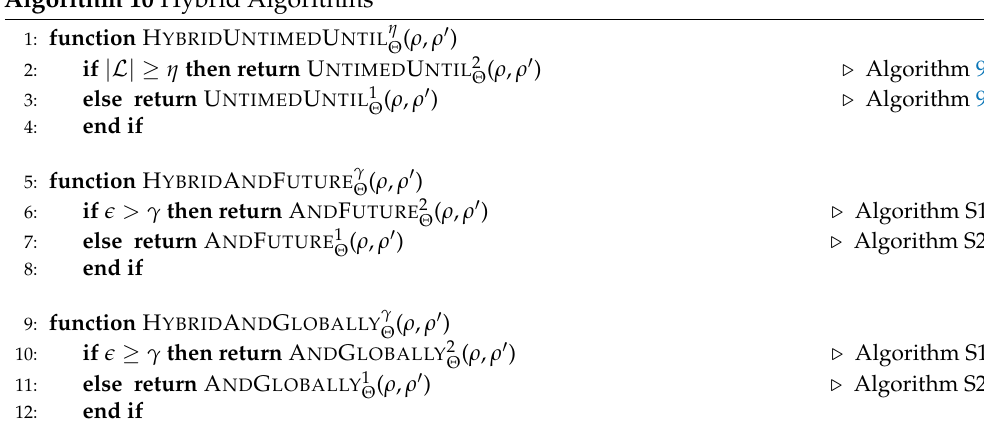
Algorithm 10 Hybrid